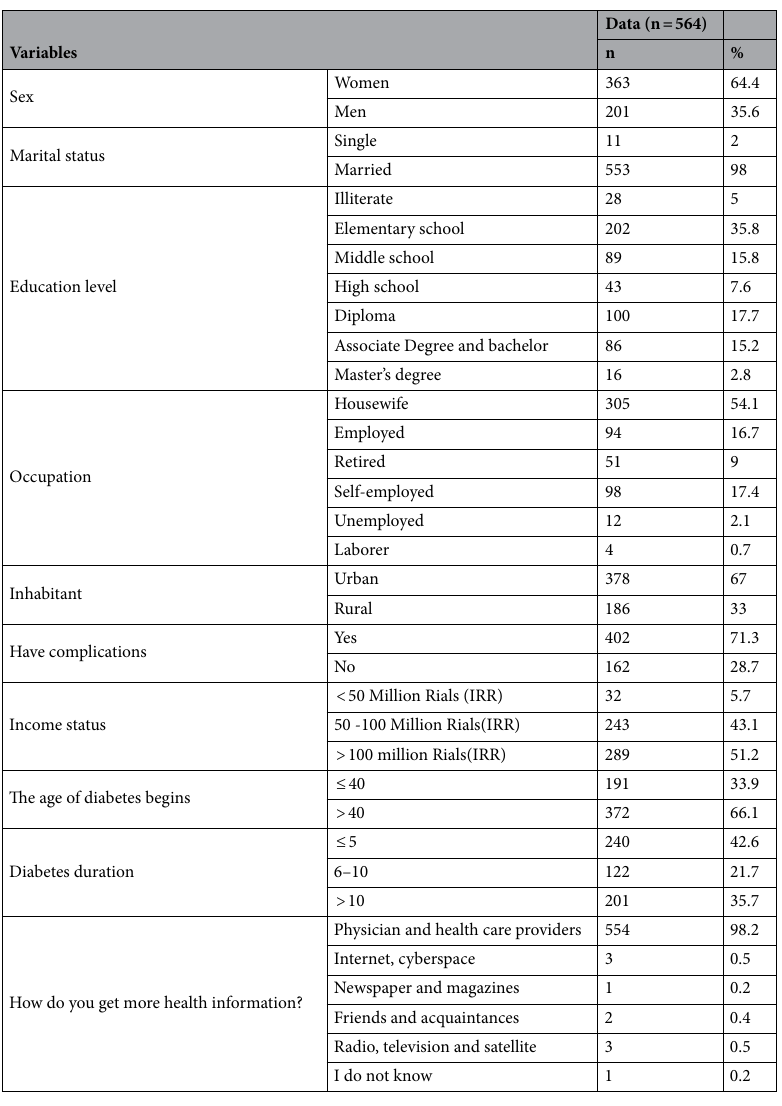
Table 1. Characteristics of demographic